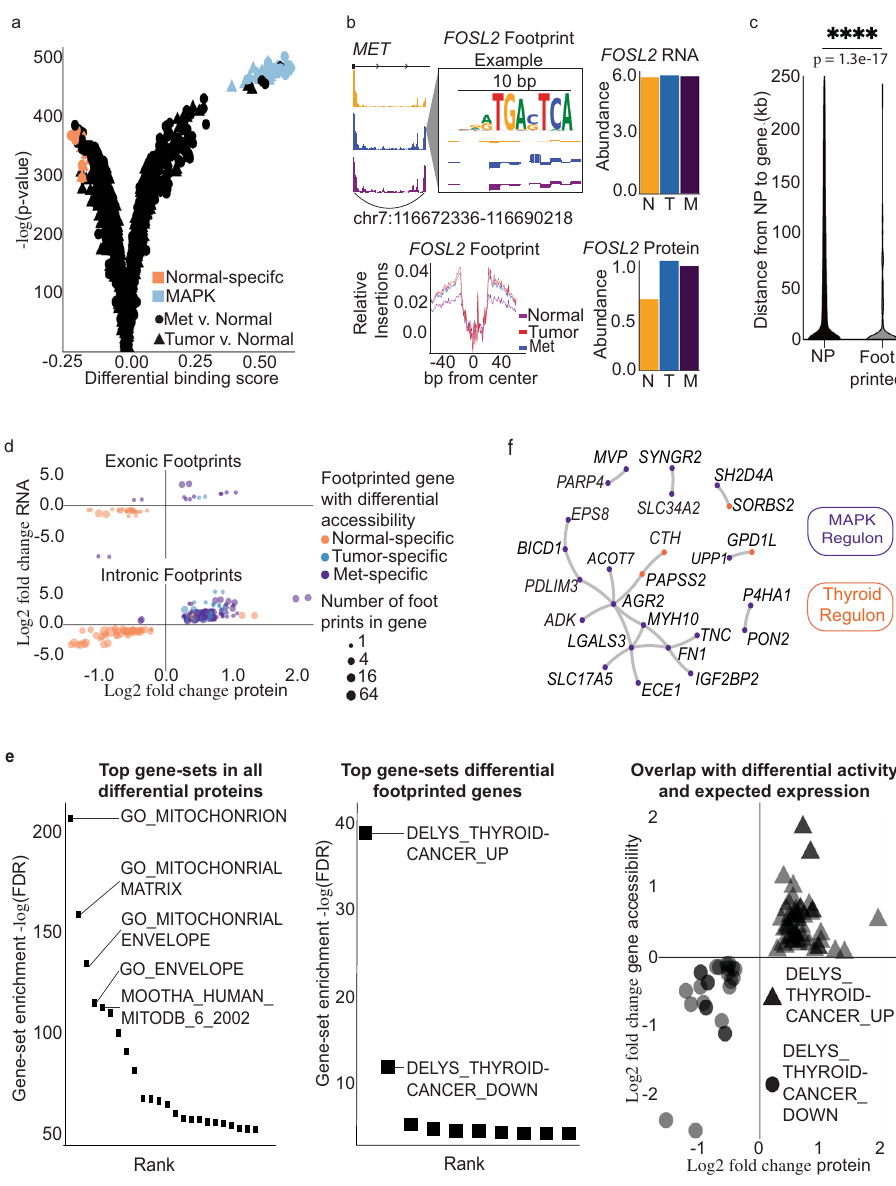
Fig. 4 Transcription factor activity in the gene body coordinates RNA and protein expression. a Differential transcription factor footprints between tumor/met and normal. b Visualization of a FOSL2, a MAPK transcription factor, footprint within the MET gene body (top left). Comparison of genome- wide transcription factor footprints of FOSL2 between normal, tumor, and met (bottom left). Comparison of RNA expression of FOSL2 between normal, tumor, and met (top right). Comparison of protein expression of FOSL2 between normal, tumor, and met (bottom right). c Distance distribution of footprinted non-promoters linked to differential expression compared to distance between not active non-promoters to their gene target. Statistical test was two-sided Fisher ’ s exact test, comparing the number of gene body non-promoters (NP) vs distal NP ( p = 1.3e − 17). d Comparison of gene-wise correlation for genes with exonic vs intronic differential footprints. e Functional signi fi cance of activity based on gene sets. Left graph shows the top gene sets enriched in the differential protein subset of genes. The middle graph describes the top gene sets of footprinted differentially active genes. The left graph shows that footprinted differentially active genes that overlap with known thyroid cancer gene sets have expected changes in protein and gene accessibility between tumor/met vs normal. f Protein – protein interaction network of tissue-type-speci fi c regulons.